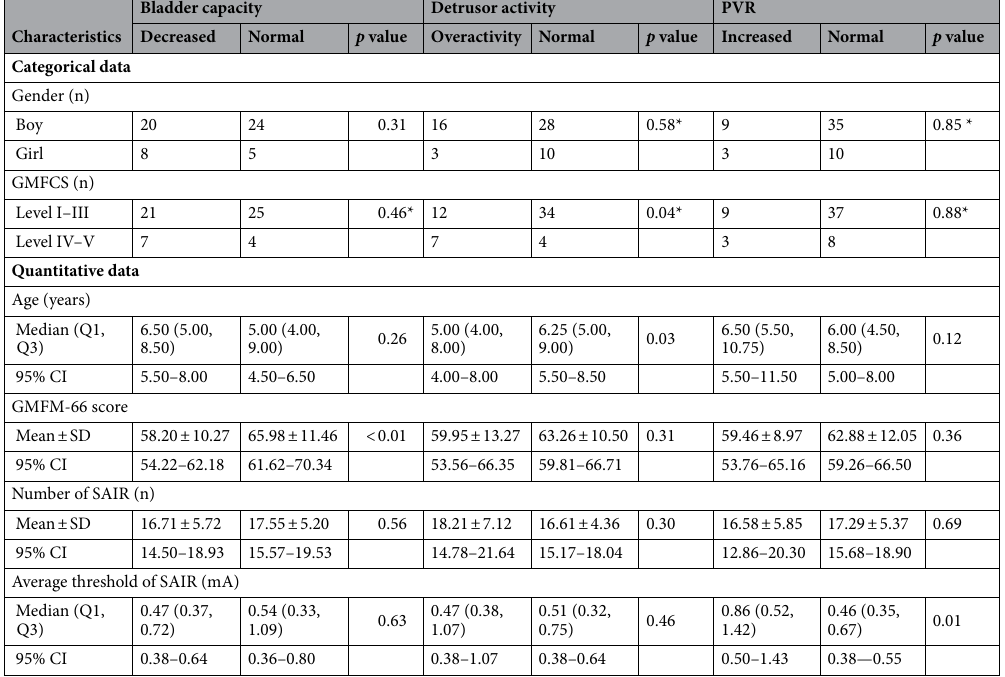
Table 2. Comparisons between cases with and without UDS abnormalities. PVR post-voiding residual, GMFCS gross motor function classification system, GMFM-66 gross motor function measurement-66, SAIR sphincter-associated input roots (rootlets). *Continuity correction.